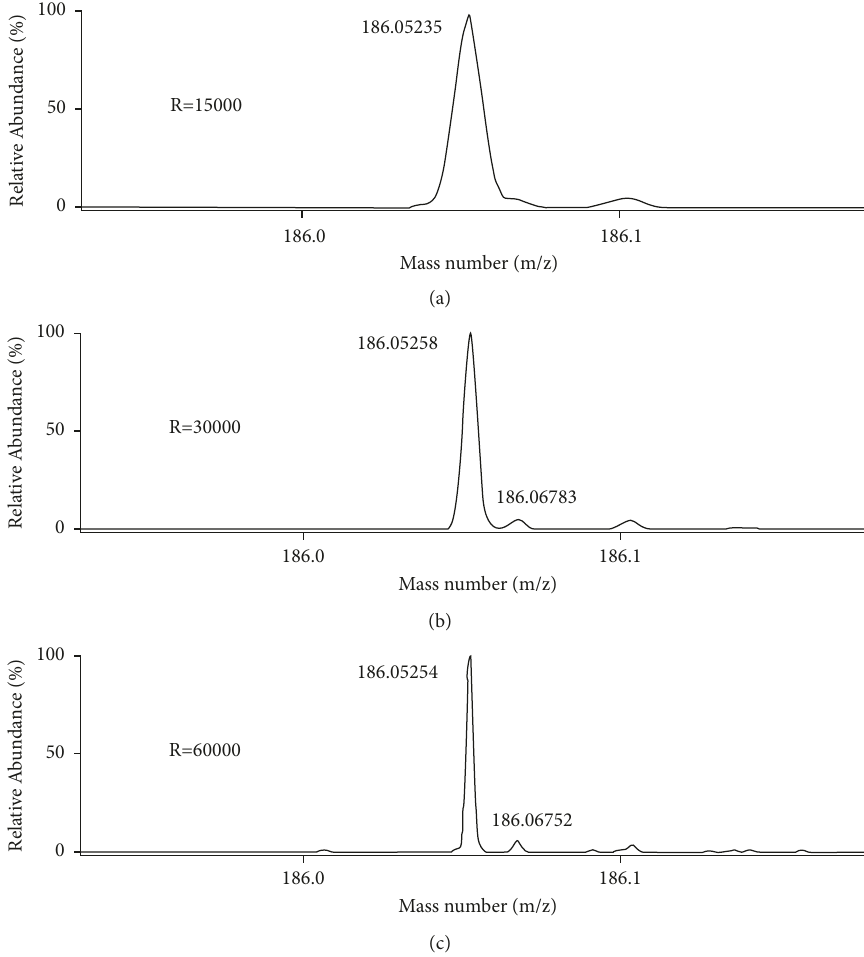
Figure 3: Effect of different resolutions ((a) 15,000, (b) 30,000, and (c) 60,000) on the quality accuracy of the qualitative ion ( m / z 186.05251) of trifloxystrobin in chrysanthemum flower.